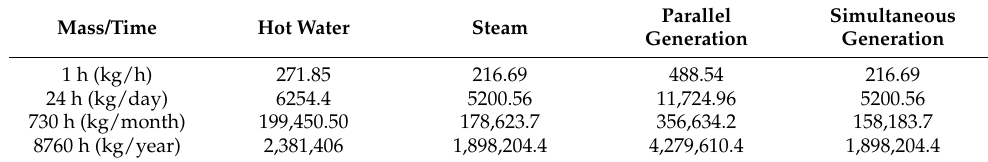
Table 8. Carbon emissions to the environment by fluid